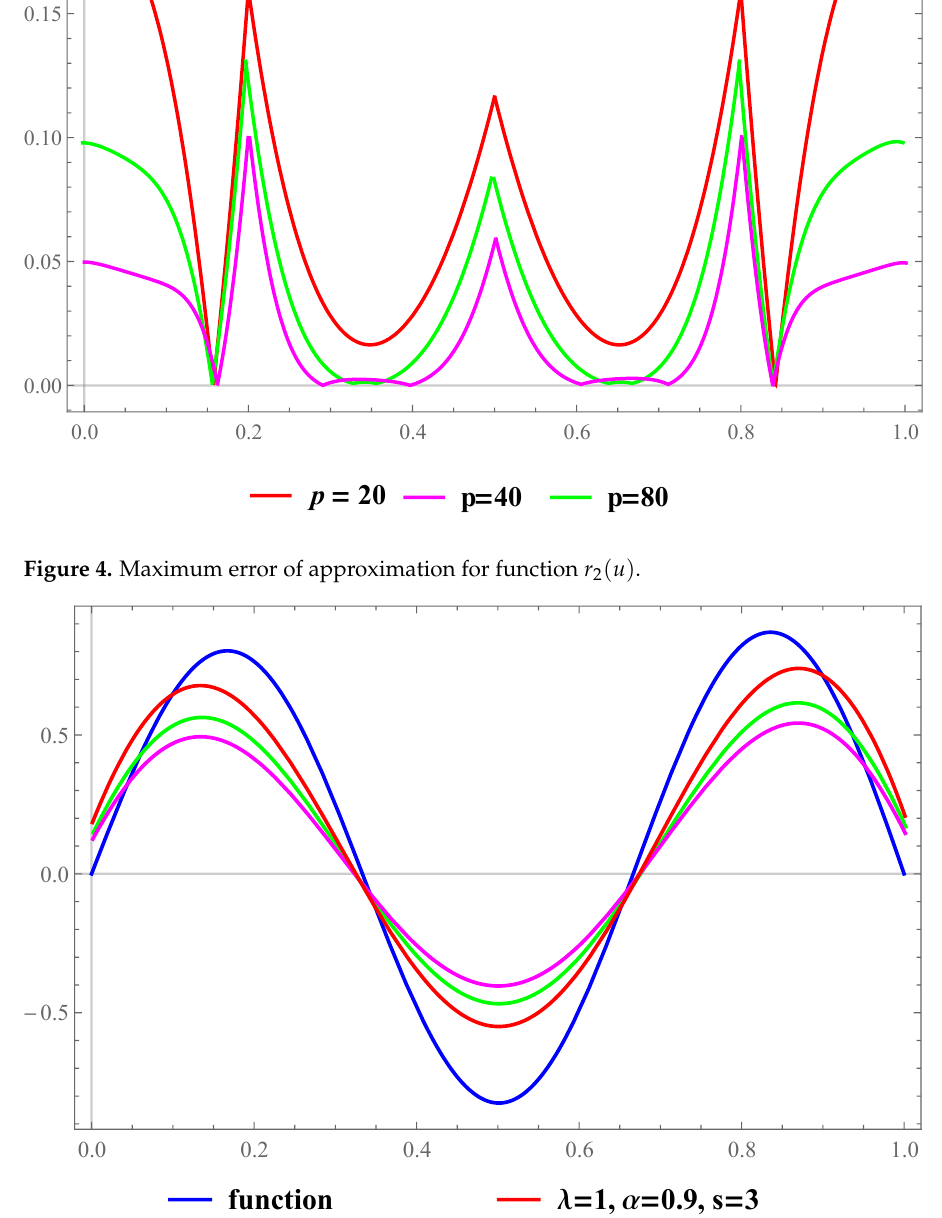
Figure 5. Approximations by K